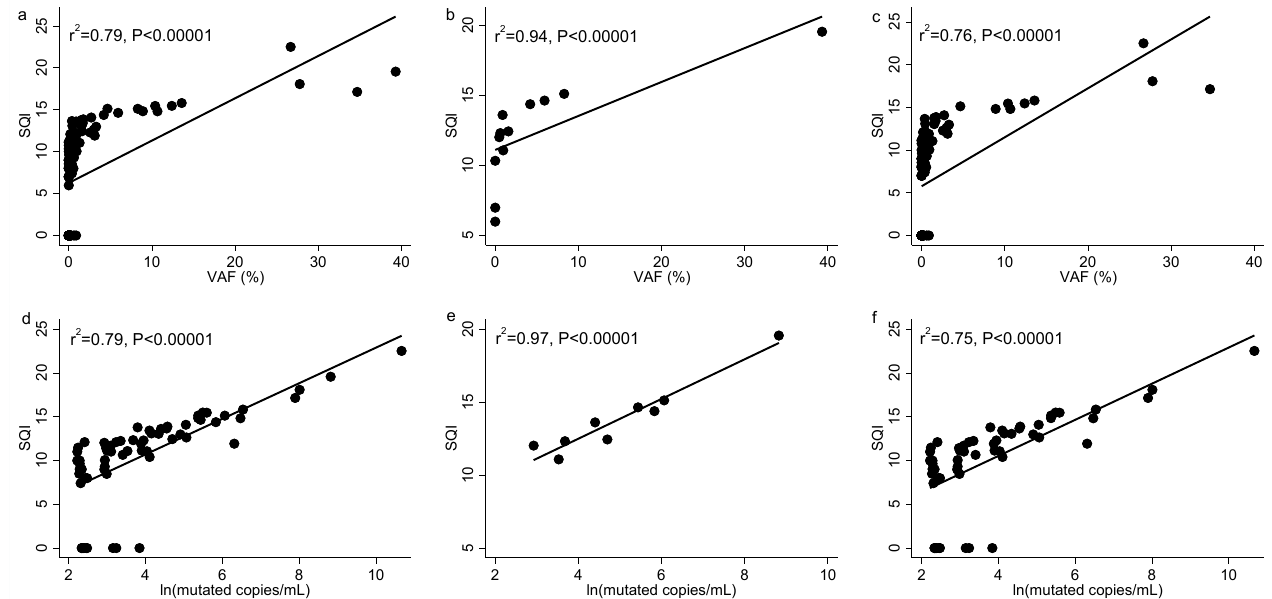
Figure 1. Correlation analysis between ( a ) SQI and VAF in all samples, ( b ) SQI and VAF in samples at the baseline before TKI treatment, ( c ) SQI and VAF in the samples after TKI treatment, ( d ) SQI and ln (mutated copies/mL) in all samples, ( e ) SQI and ln (mutated copies/mL) in samples at the baseline before TKI treatment, and ( f ) SQI and ln (mutated copies/mL) in samples after TKI treatment. Mutated copies/mL were transformed to their natural logarithm to ease graphical repre- sentation.